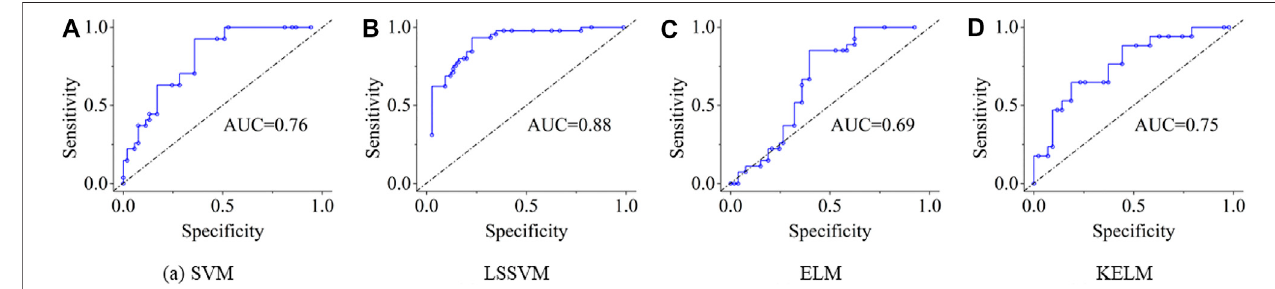
FIGURE 8 | ROC curves of the bearing failure classi fi cation outcome.